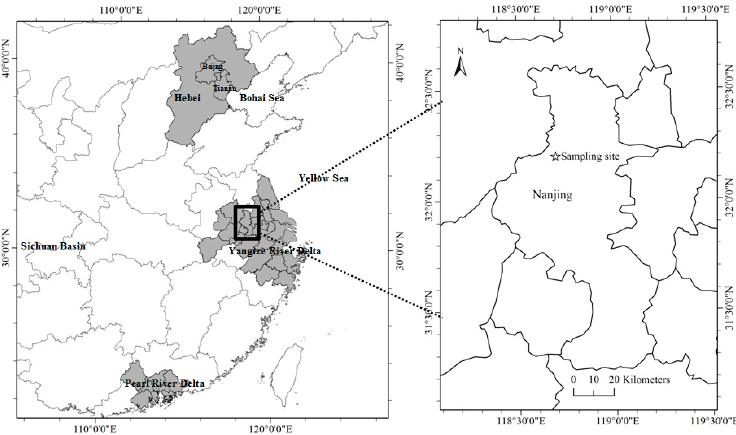
Figure 1. Location of the sampling site.